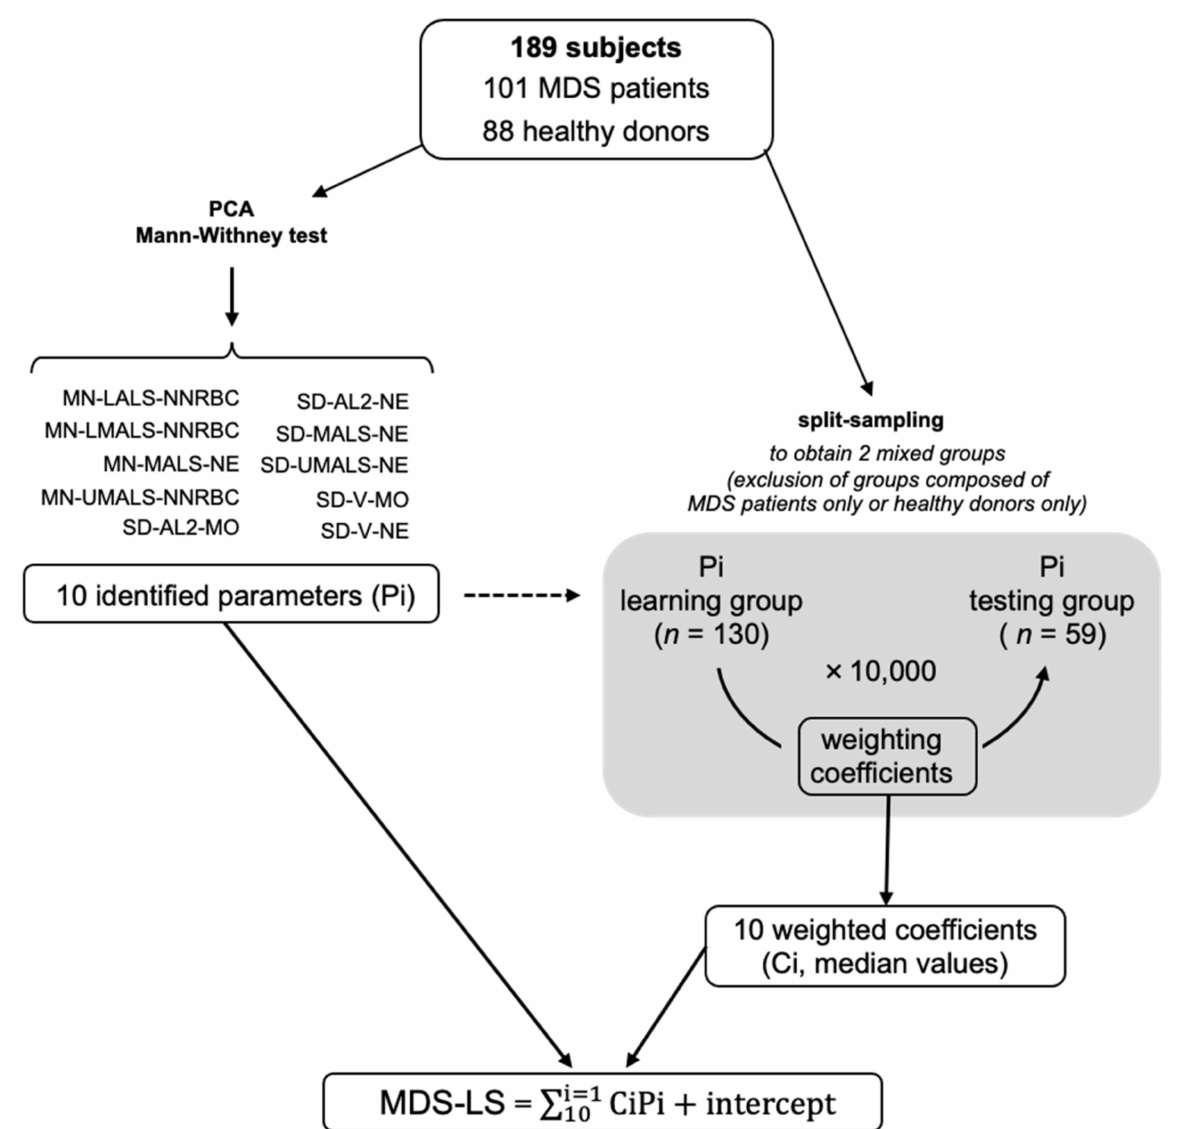
Figure 3. Mathematical model construction. Schematic representation of randomization to “learning” and “testing” groups for